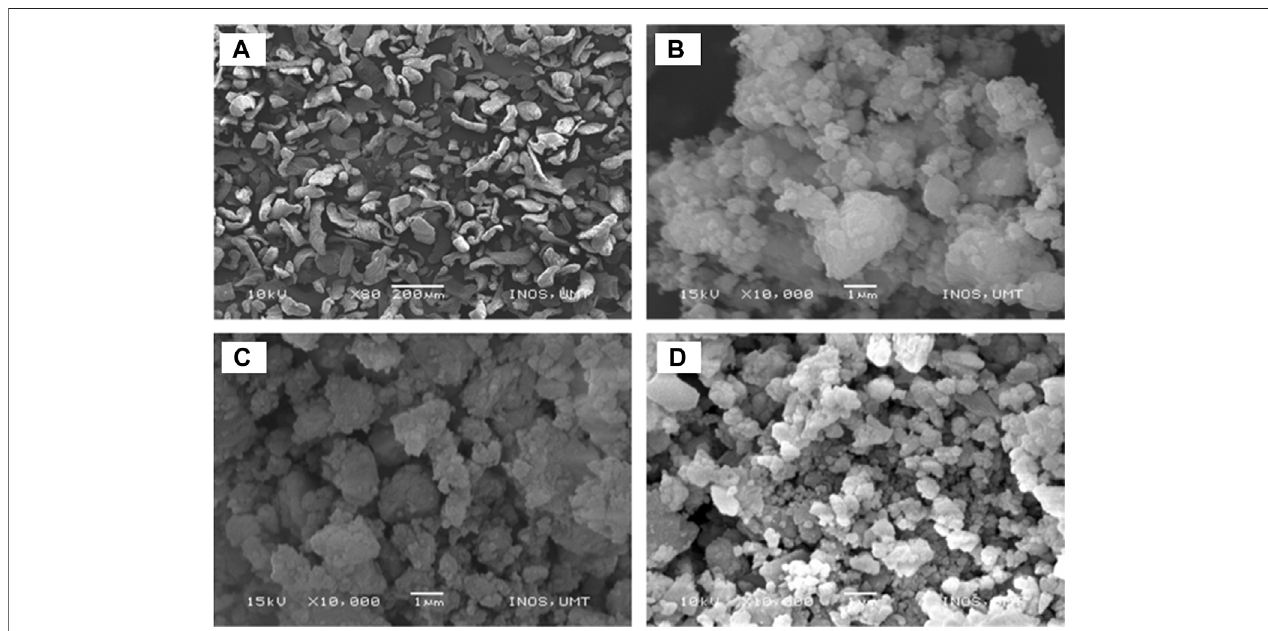
FIGURE9| SEMimagesforthe (A) as-receivedMgH 2 , (B) as-milledMgH 2 , (C) 4MgH 2 -LiAlH 4 ,and (D) 4MgH 2 -LiAlH 4 +10 wt.%K 2 ZrF 6 (HalimYap&Ismail,2017).